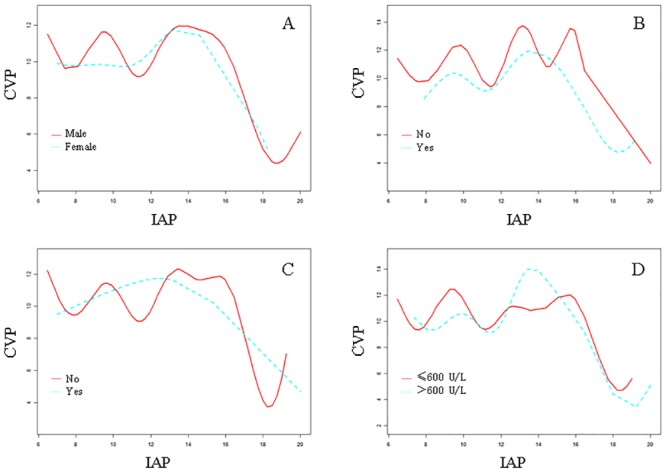
Smoothing curve of CVP (cmH2O) by IAP (mmHg) in different groups considering.A: patients' gender; B: local complication; C: ascites; D: serum amylase.